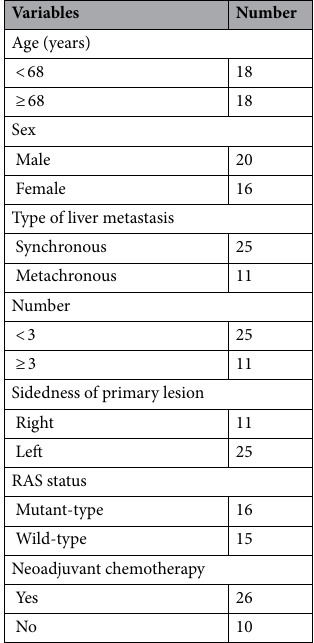
Table 1. Characteristics of the